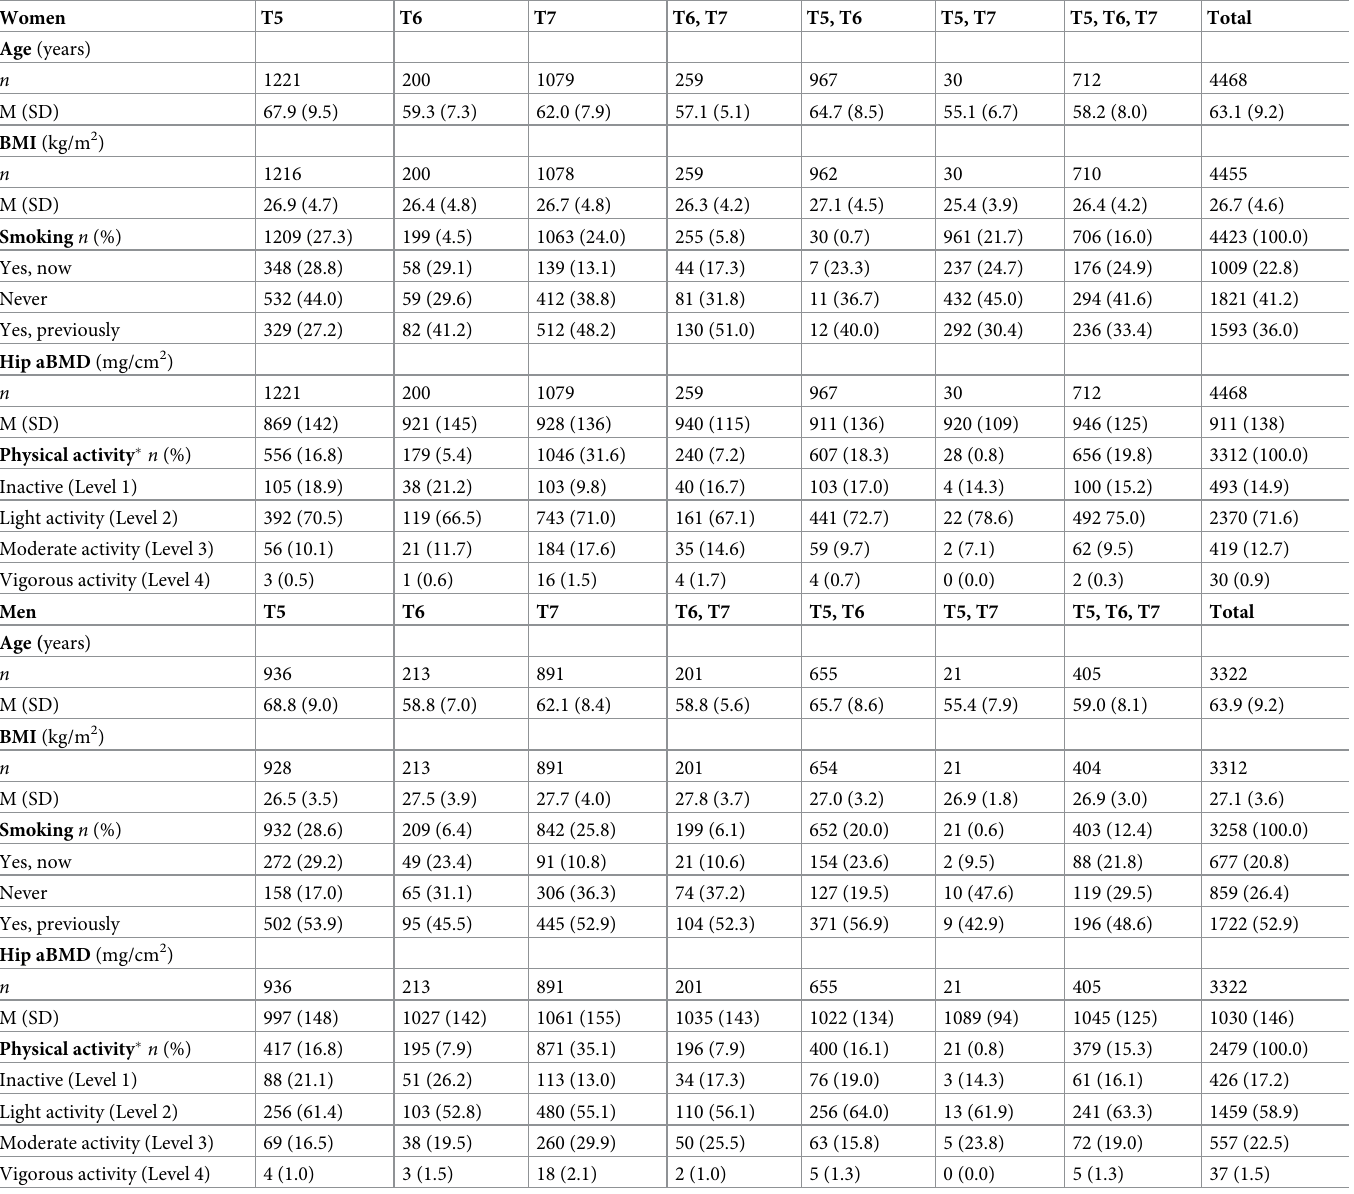
Table 1. Sample characteristics stratified by sex and survey